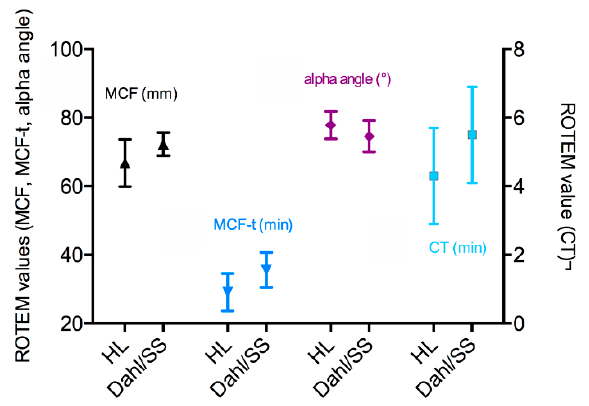
Figure 3. Frequency spectrum of storage (G’) and loss modulus (G”) at low deformation ( γ ( ω ) = 0.01%): ( a ) at +15 minutes following start of clotting, ( b ) at +45 minutes following start of clotting. Although the shear moduli have higher values in the Dahl/SS strain (purple) compared with the HL strain (grey), the linear behavior of the clots is similar. In all cases, G” displays a minimum between 10 and 20 rad/s.